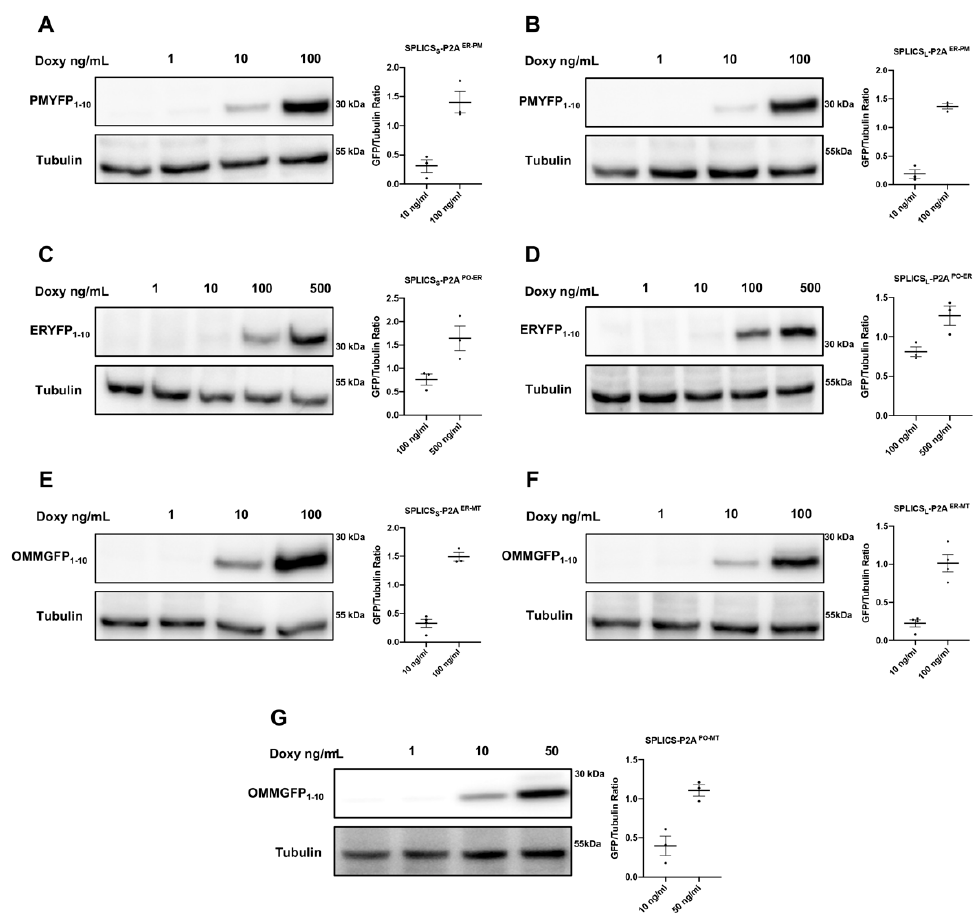
Figure 2. Western blotting analysis of HeLa polyclonal stable cell lines expressing SPLICS S/LER-PM and SPLICS S/LPO-ER , SPLICS S/LER-MT and SPLICS LPO-MT . ( A – D ) Expression levels YFP1-10 proteins in HeLa stably transfected with SPLICS S/LER-PM or SPLICS S/LPO-ER and incubated with increasing concentrations of doxycycline for 24 h. ( E – G ) Expression levels of OMMGFP1-10 proteins in HeLa expressing SPLICS S/LER-MT or SPLICS LPO-MT upon incubation with increasing concentrations of doxycycline for 24 h. An anti-GFP antibody was used to detect both YFP and GFP. Equal amount of total loaded lysate was verified by incubation with anti- β Tubulin antibody.